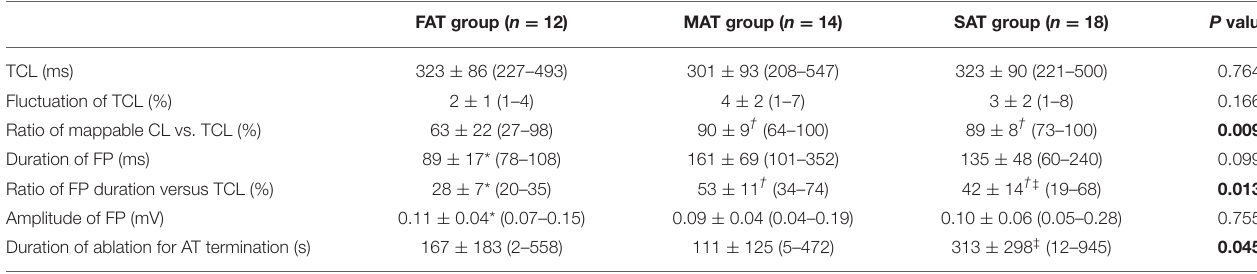
TABLE 2 | Comparison of electrophysiological data between different atrial tachycardia groups.